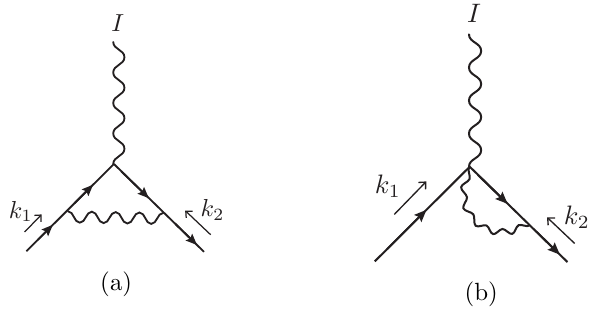
Figure 3. Corrections to the three-point